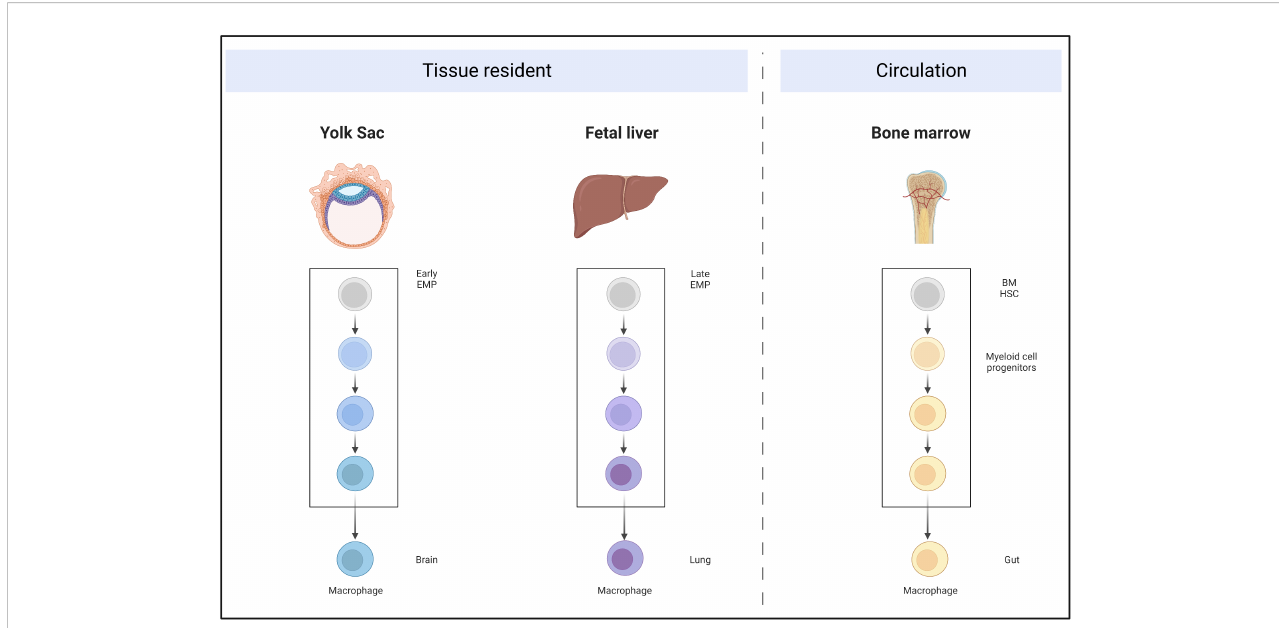
FIGURE 2 Self-proliferative tissue-resident macrophages originate from the yolk sac and fetal liver, migrate into the peripheral organs during embryonic development, and mature. Circulating macrophages are derived from bone marrow HSCs, which develop into myeloid-committed stem cells and further develop into